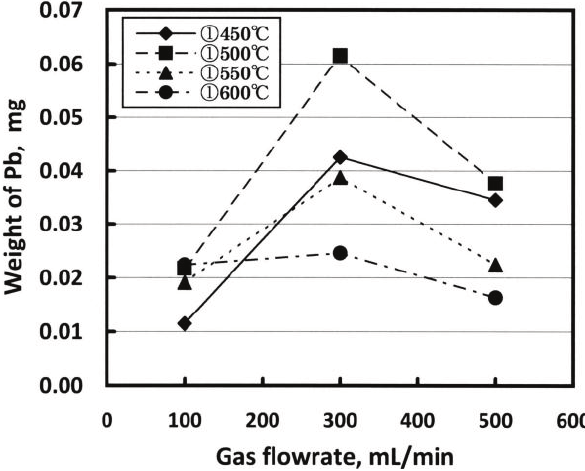
Figure 13. Influence of gas flow rate on the weight of Pb droplets in molten